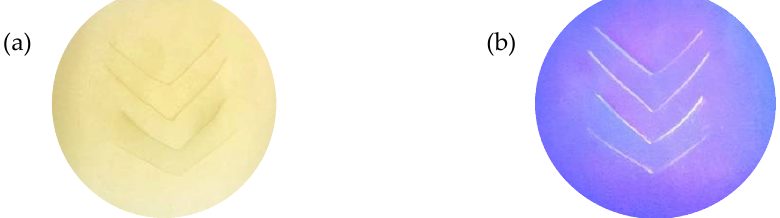
Figure 3. Photograph of LC films for solid sample fluorescence analysis ( a ) film under visible light, ( b ) film under UV light.